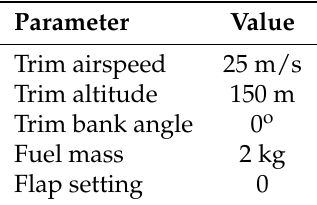
Table 5. Selected Trimming Parameters.